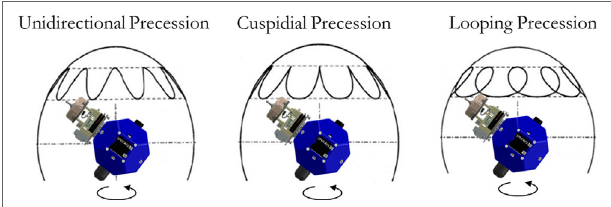
FigUre 8 | Diagrams of precession types for tumbling Target